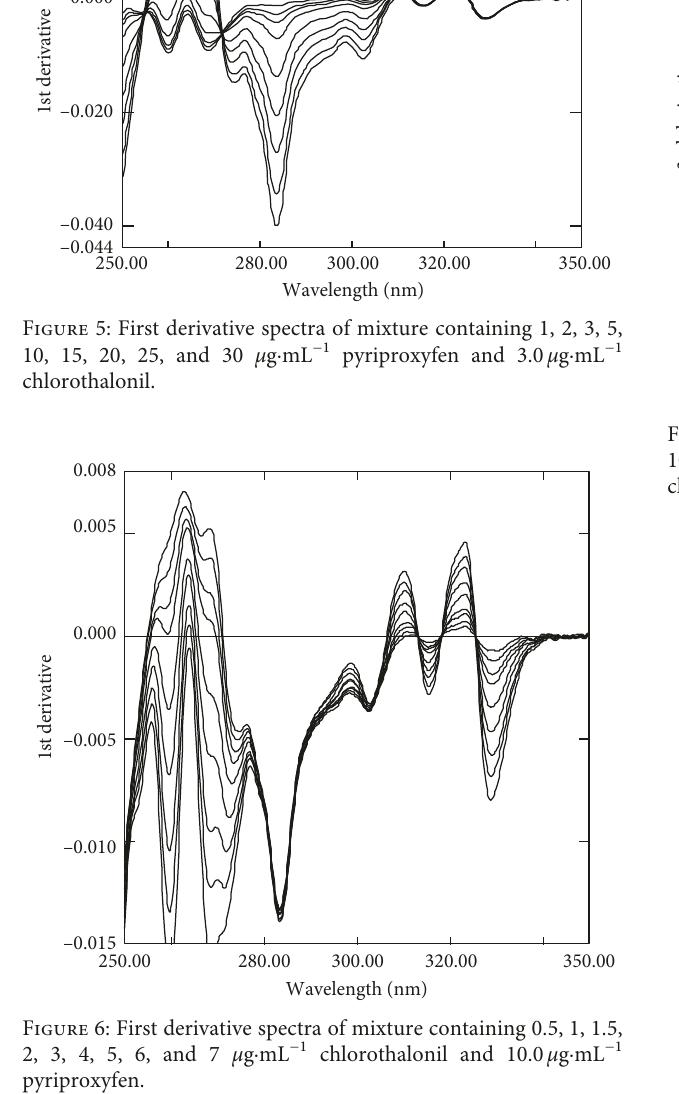
Figure 8: Second derivative spectra of mixture containing 0.5, 1, 1.5, 2, 3, 4, 5, 6, and 7 μ g · mL − 1 chlorothalonil and 10.0 μ g · mL − 1